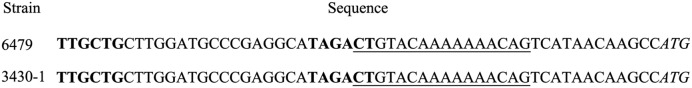
Sequences upstream of the intI1 gene. The SOS boxes are underlined. Start codons are italicized. -35 and -10 consensus sequences are in bold type.